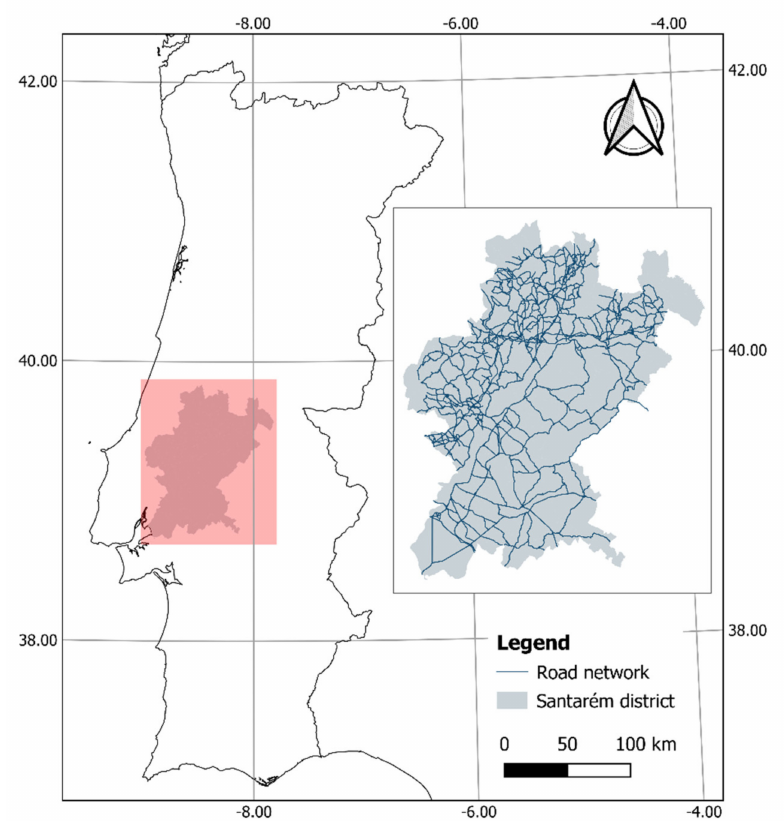
Figure 2. Location of the case study area in